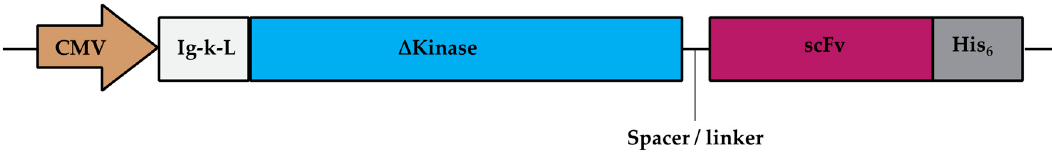
Figure 4. Schematic representation of an expression cassette for a recombinant immunokinase fusion protein. Under the expression of a strong CMV promoter, the N-terminal Igkappa leader sequence allows direction of expressed protein into the media of the expressing cell line. A C-terminal His 6 tag sequence allows for affinity purification of the recombinant protein via an IMAC purification system.